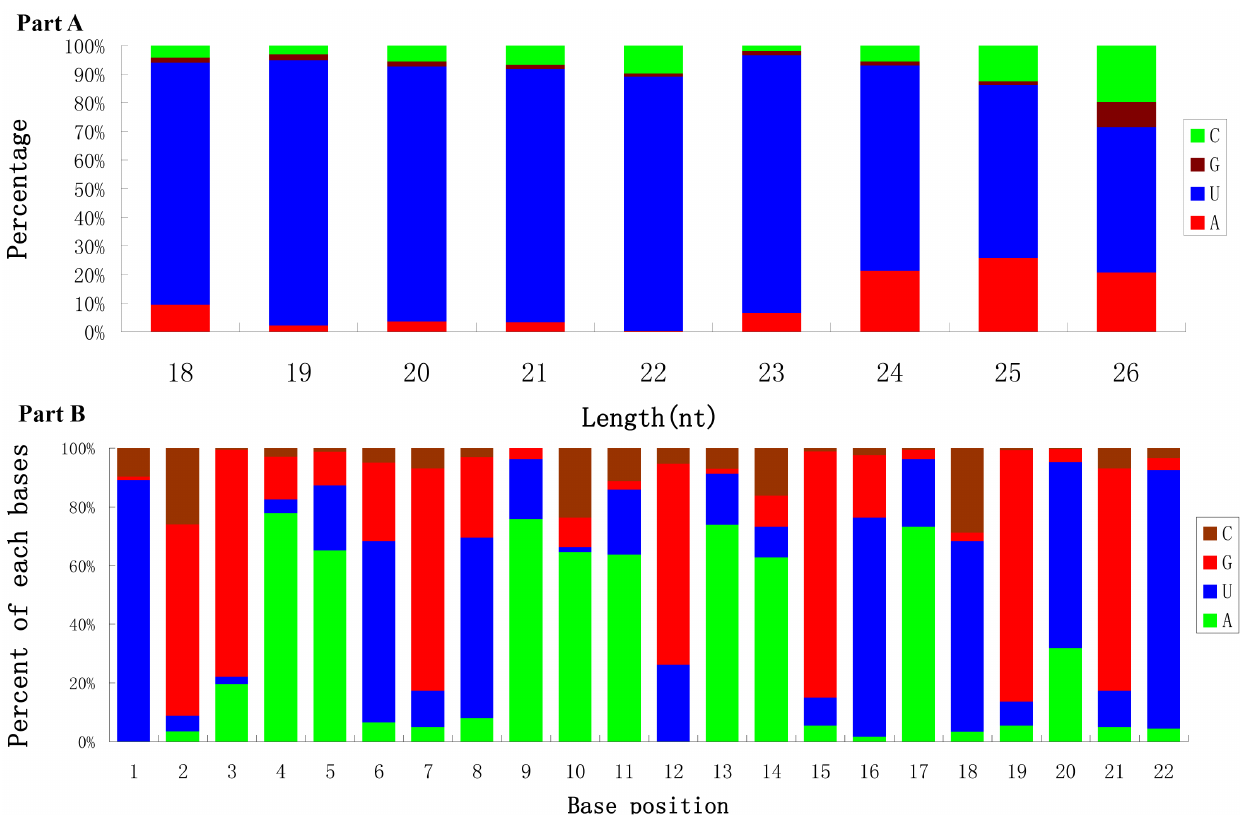
Figure 3. Analyses of the nucleotide bias at the first position of miRNAs and each position of miRNAs with length of 22 nucleotides. A: The nucleotide bias at the first position of miRNAs. B: The nucleotide bias at each position of miRNAs with length of 22 nucleotides.